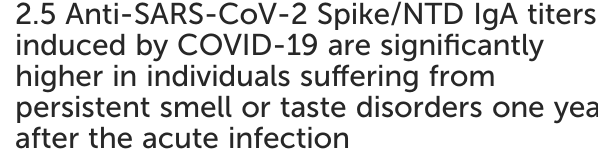
TABLE 2 Vaccination status of naive individuals (COVID-) and previously infected individuals (COVID+) at the last visit (V3). Participants at visit three